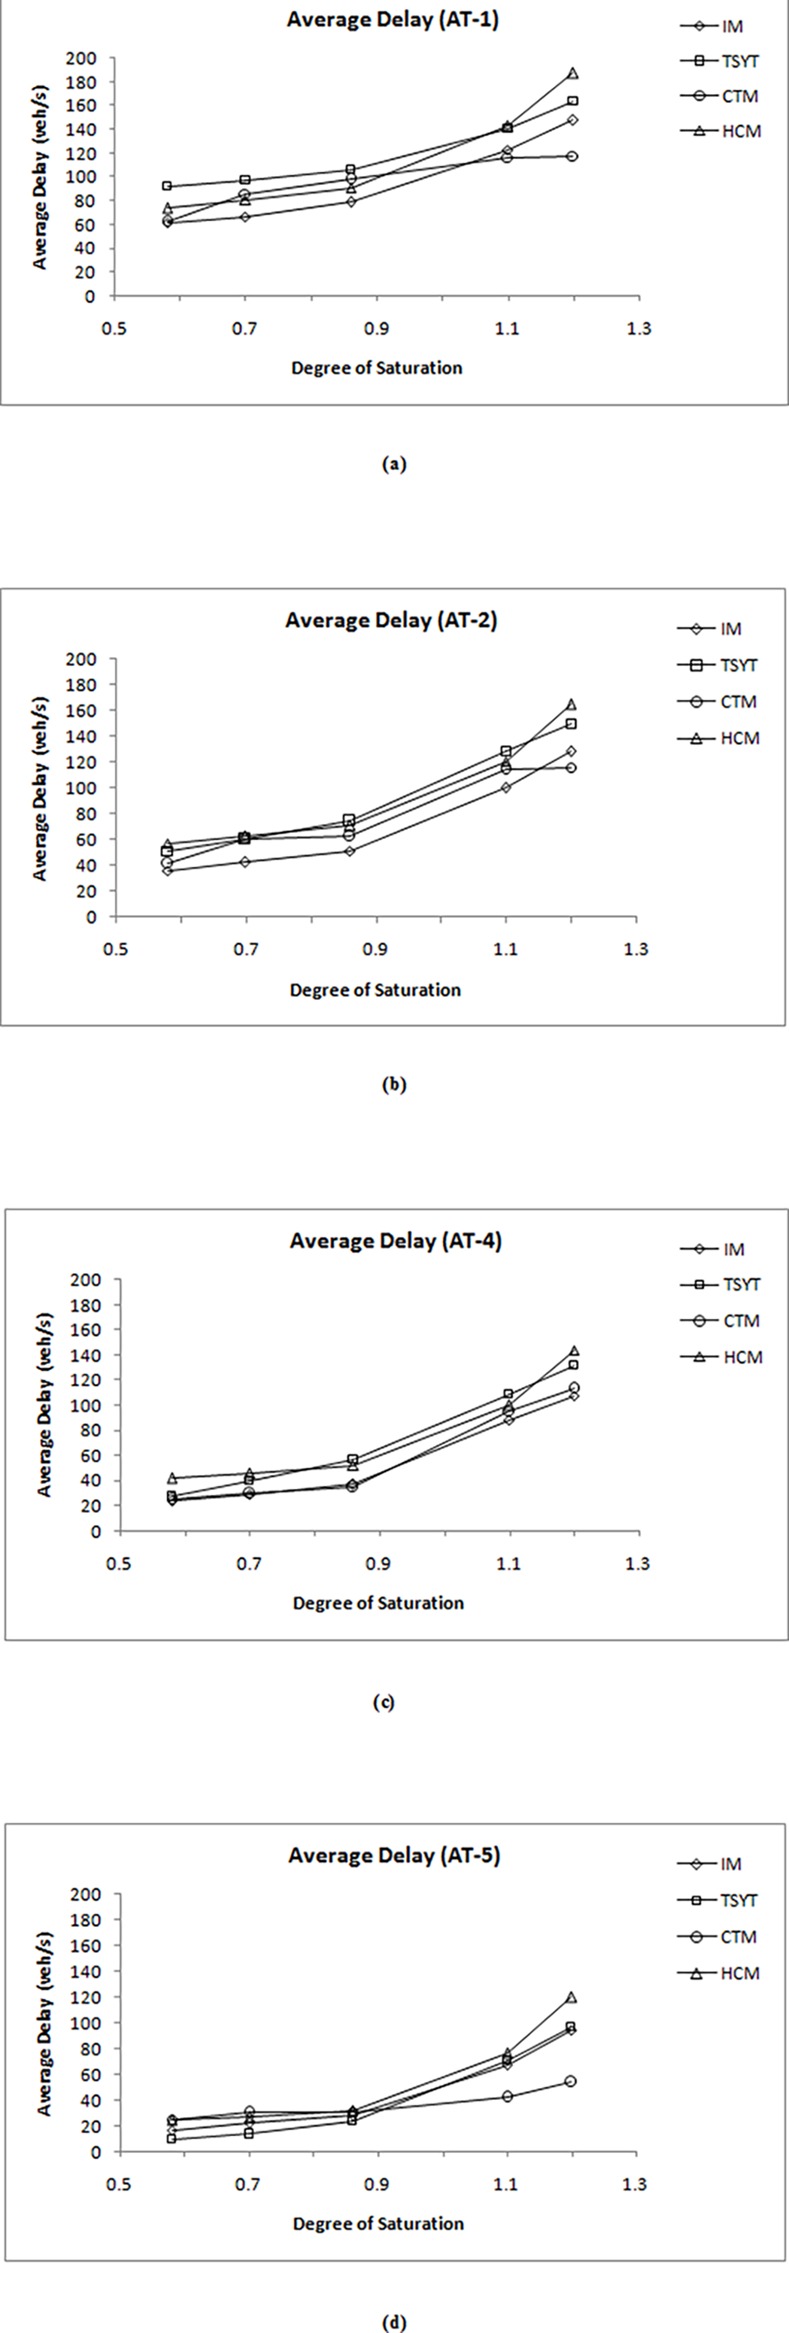
Comparison of average delays for all scenarios.